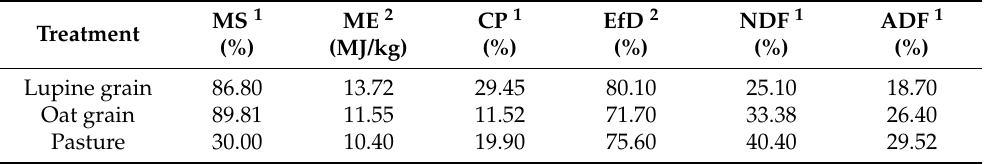
Table 1. Chemical composition of the grains used as a supplement and the pasture used as a base diet (MS: dry matter; ME: metabolizable energy; CP: crude protein; EfD: effective degradability of crude protein; NDF: neutral detergent fiber; ADF: acid detergent